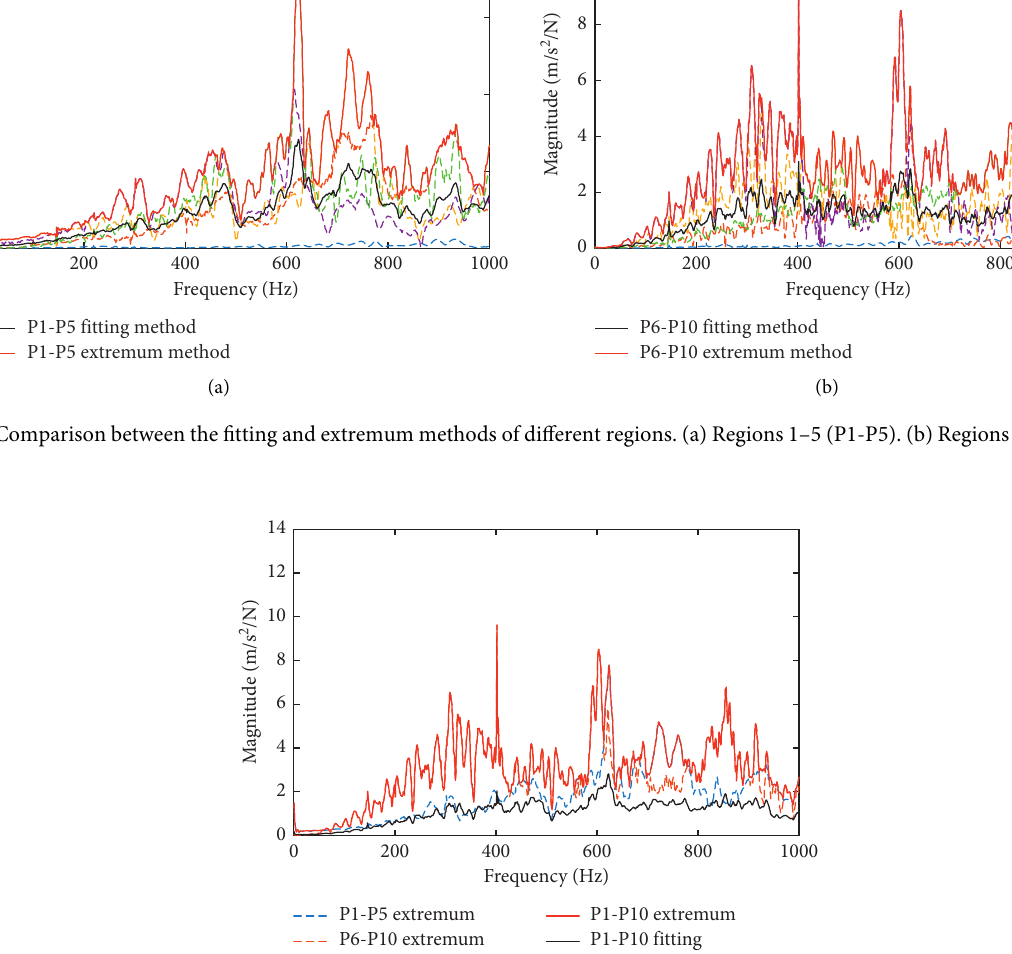
Table 1: Dynamic parameters with two methods.